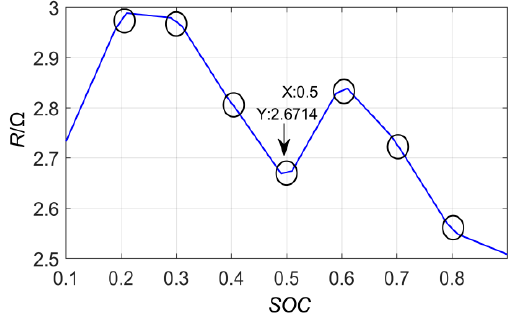
Figure 10. Optimized data curve.